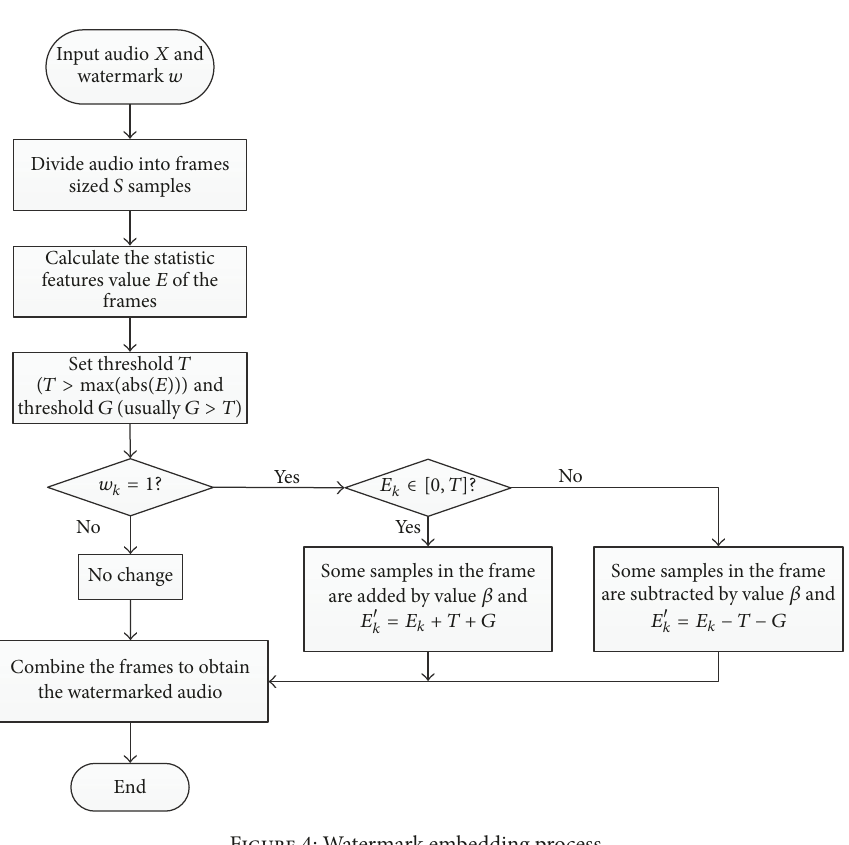
Figure 4: Watermark embedding